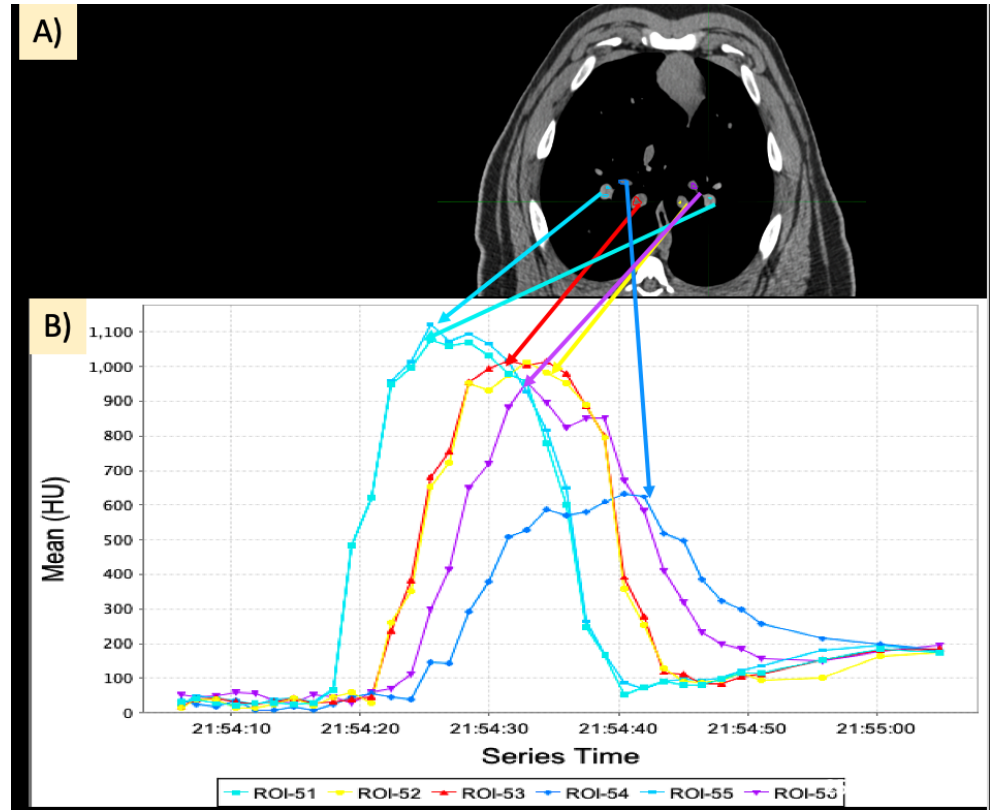
Figure 9. Dynamic contrast-CT data in different vasculature. ( A ) Different contours placed in different vasculature in the lung. ( B ) Corresponding contrast flow